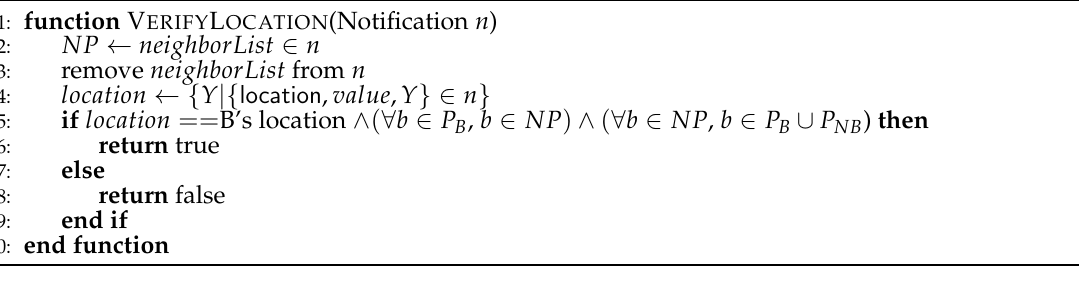
Algorithm 6 : at broker B , verify location (Assigned-brokers architecture, CLS)